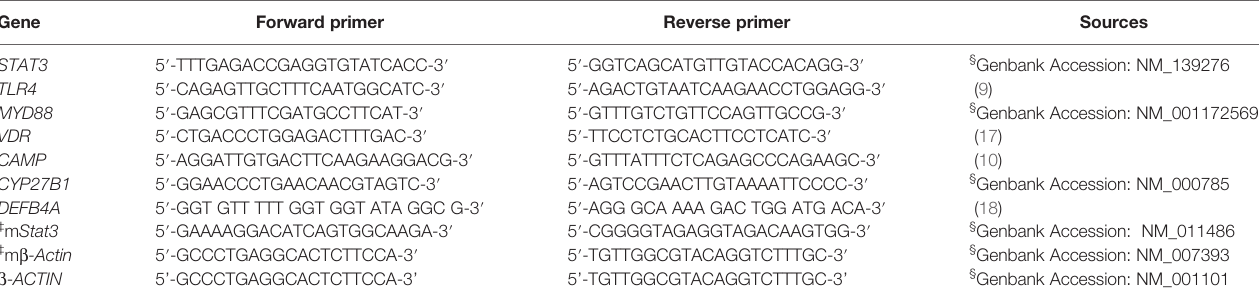
TABLE 1 | Primers used for